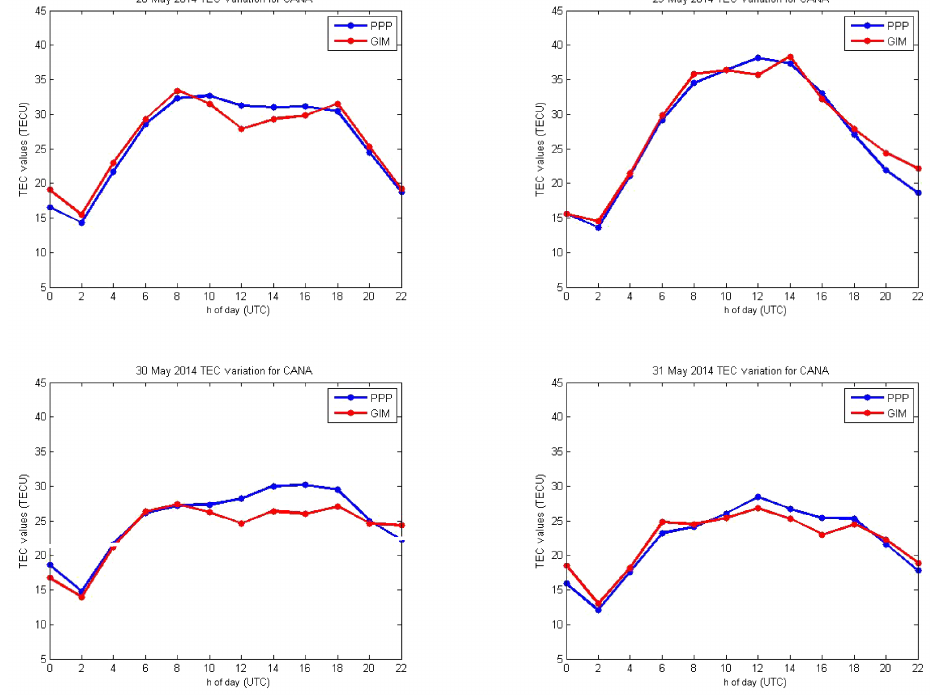
Figure 4. Representation of PPP and GIM-TEC values for the CANA